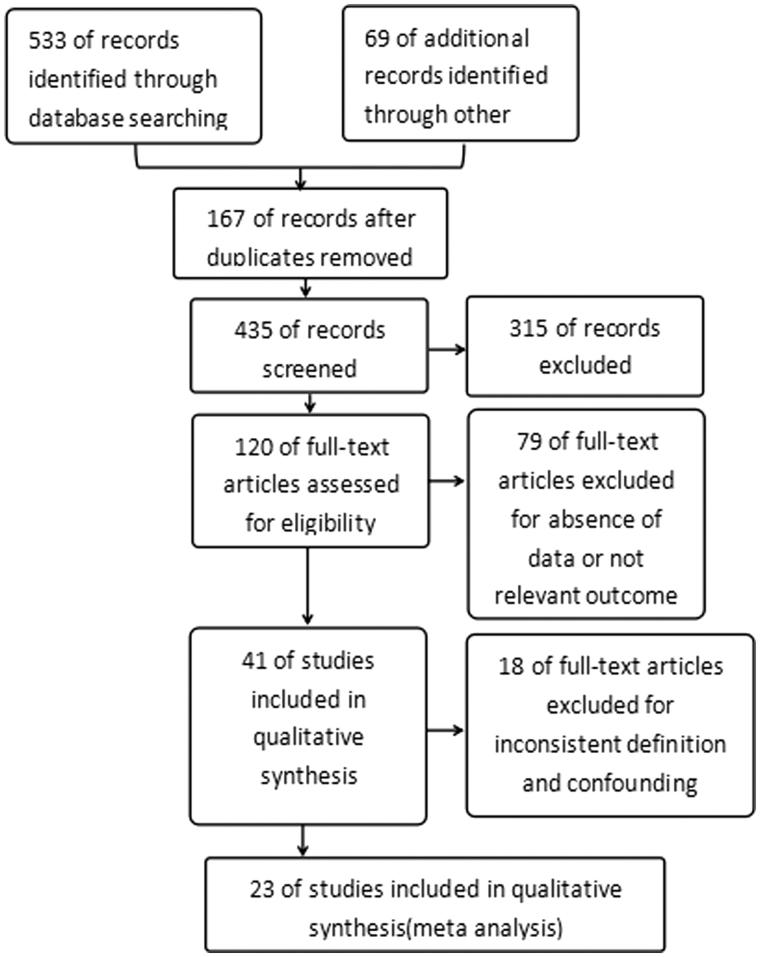
Study flow diagram of the meta-analysis.